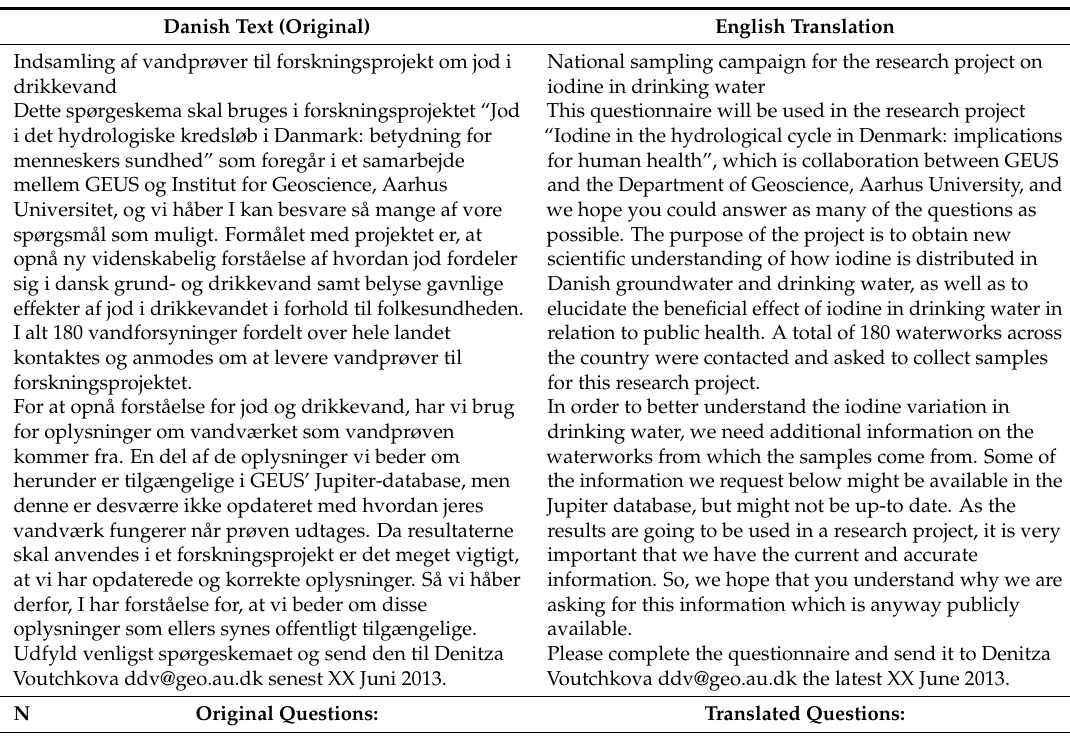
Table A1. Questionnaire (in Danish and translated in